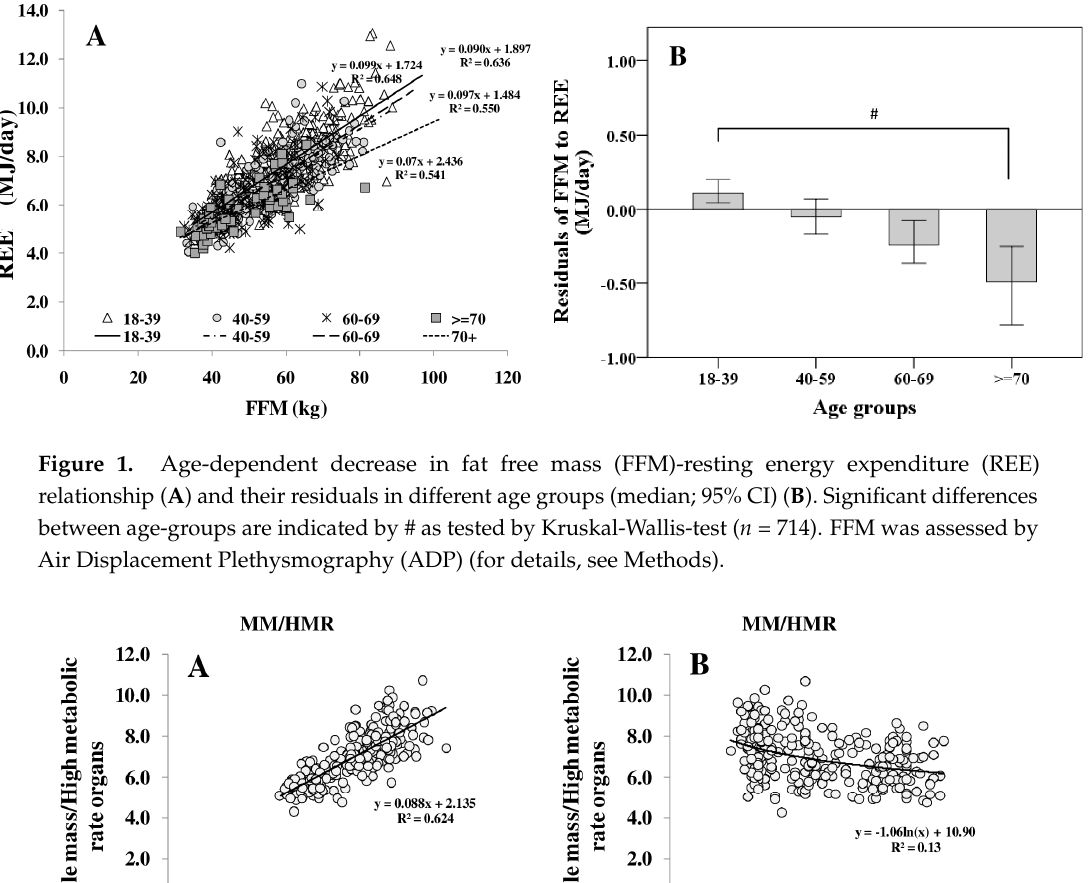
Figure 2. Relationship between FFM and the ratio of muscle mass (MM) to high metabolic rate organs (HMR) per kg ( A ) and between the MM/HMR ‐ ratio and age ( B ). HMR is the sum of masses of brain, heart, liver and kidneys.FFM was assessed by ADP, organ masses were assessed by whole body Magnetic Resonance Imaging (MRI) (for details, see Methods) ( n = 369).